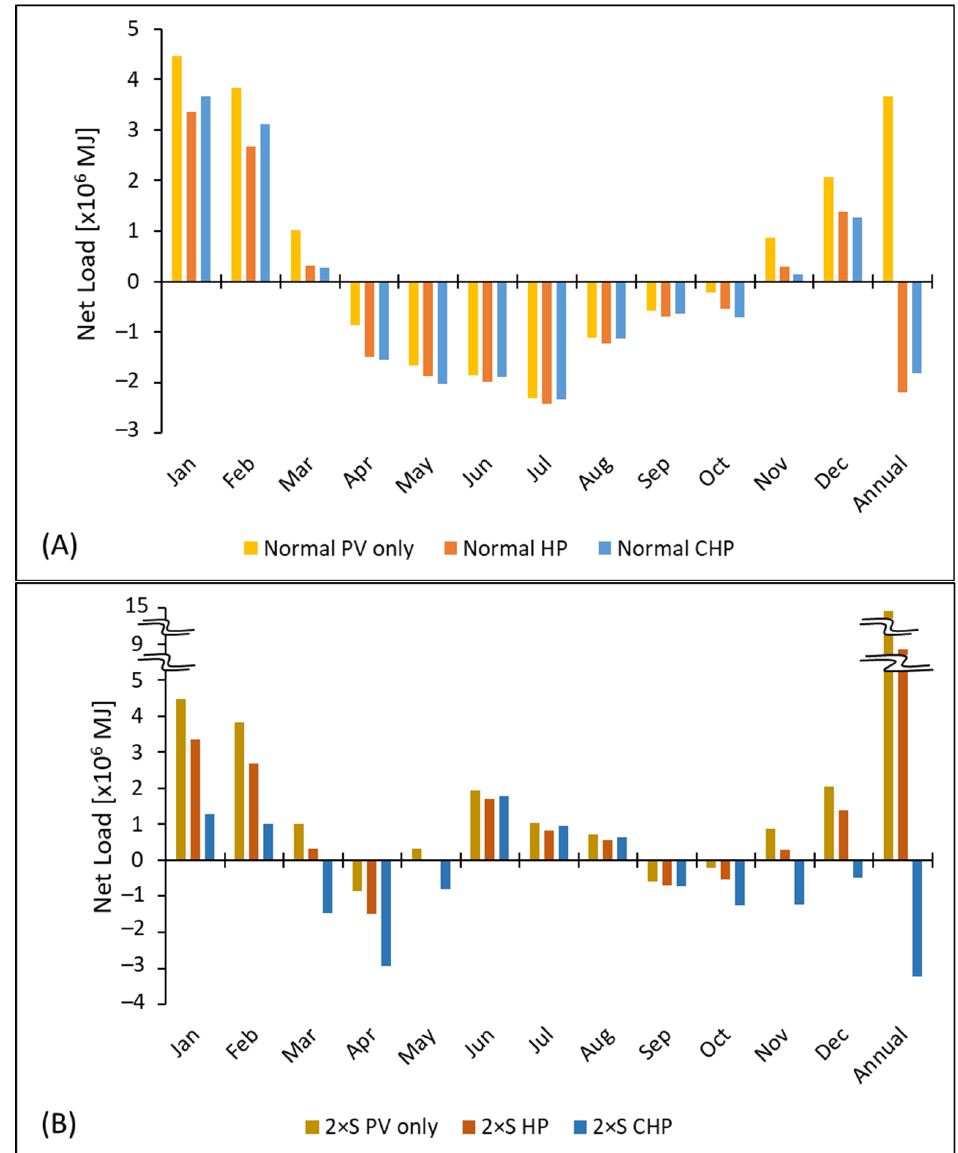
Figure 4. NWC monthly net load for each load/generation scenario. Negative load values indicate a surplus of energy generation. Plot ( A ) is Normal load with PV only, Heat Pump (HP), and base CHP generation scenarios. Plot ( B ) is 2 × summer (2 × S) load with PV only, HP, and large CHP generation scenarios. The net annual load is included at the far right, which is negative for the scenarios that achieve net-zero energy.